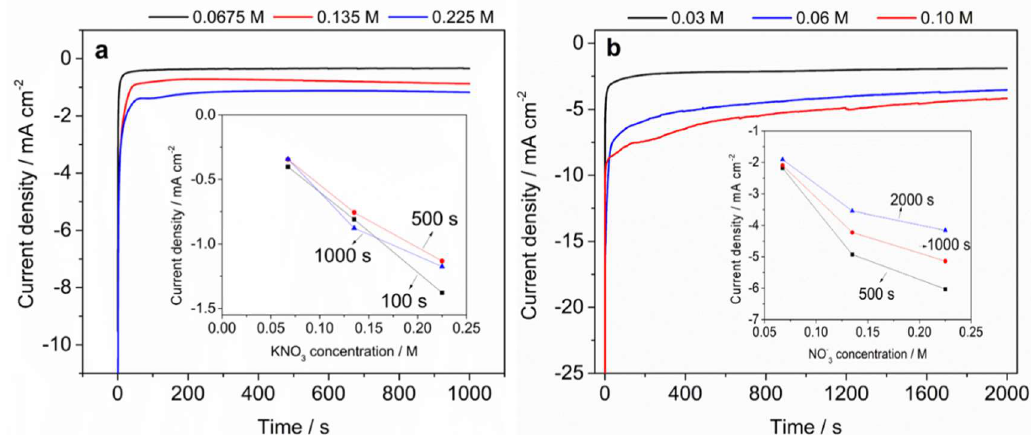
Figure 3. Current transients recorded at FeCrAlloy foams at − 1.2 V vs. SCE in ( a ) KNO 3 and ( b ) Mg/Al-NO 3 (Mg/Al = 3/1) solutions. The insets present the dependence of current densities on total nitrate concentration at different times. Adapted from [55].